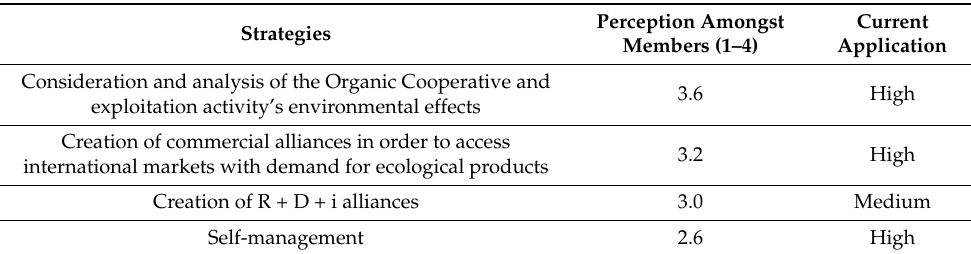
Table 2. Political-contextual dimension strategies